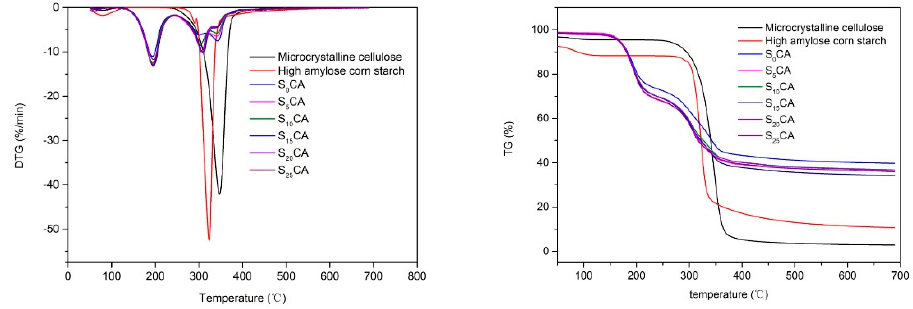
Figure 4. The TG and DTG curves of MCC, starch, and the aerogels with different starch content.